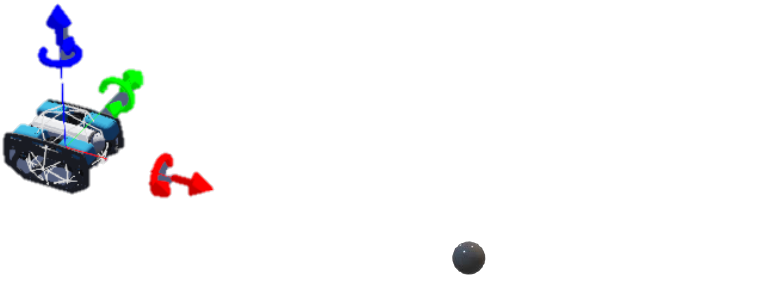
Figure 8. AUV simulated in the Webots simulator with the ball represents the targeted origin O s